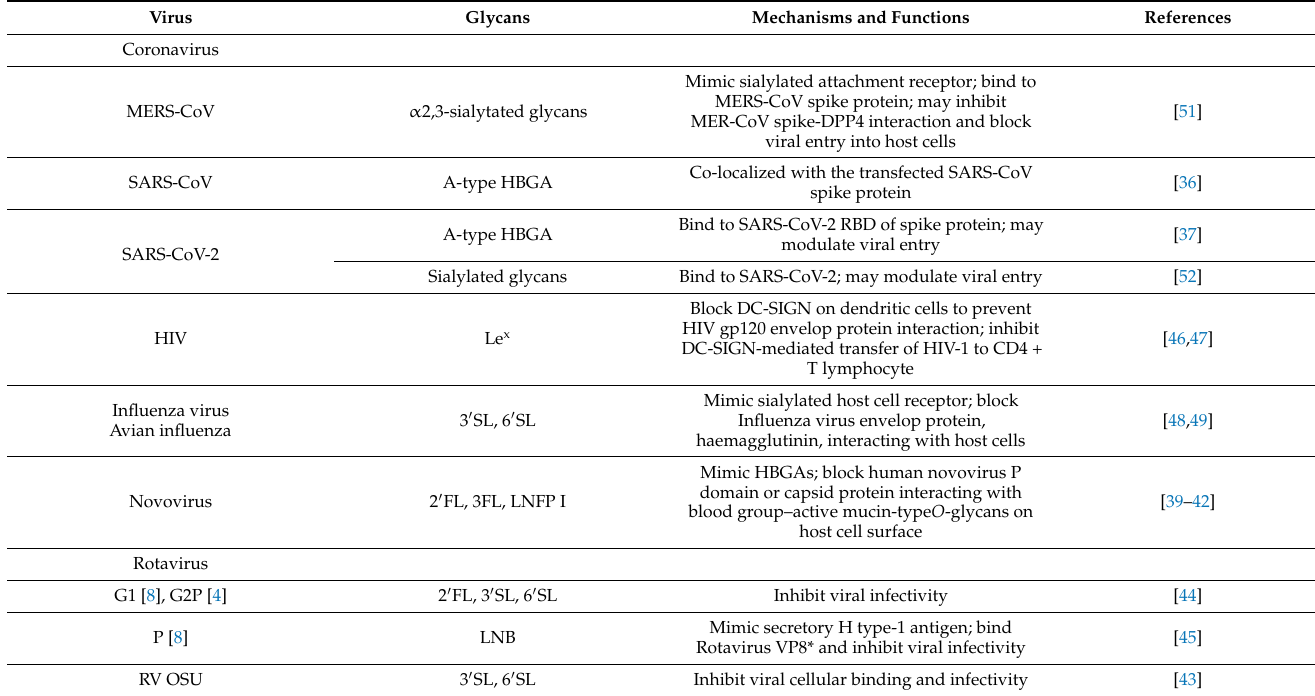
Table 1. Evidence supporting antiviral effects of hMOS via the receptor decoy